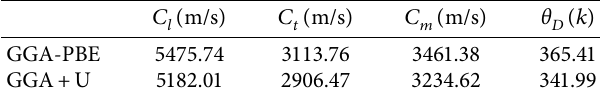
Table 4: Calculated values of sound velocities and Debye tem- perature of CaHfS 3